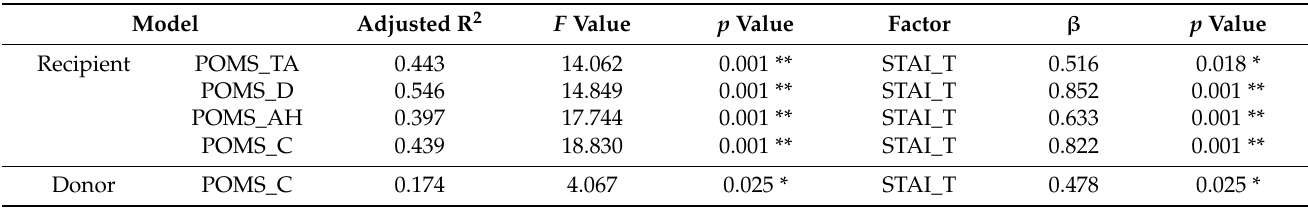
Table 7. Significant impact factors of STAI on choosing between PEKT and PDKT. Multicollinearity was suspected if the VIF value was greater than 10. * p < 0.05, ** p < 0.01: significant effects of STAI scores on the direct/secondary impact factors for choosing between PEKT and PDKT among recipients and donors according to stepwise multiple regression analysis with robust standard